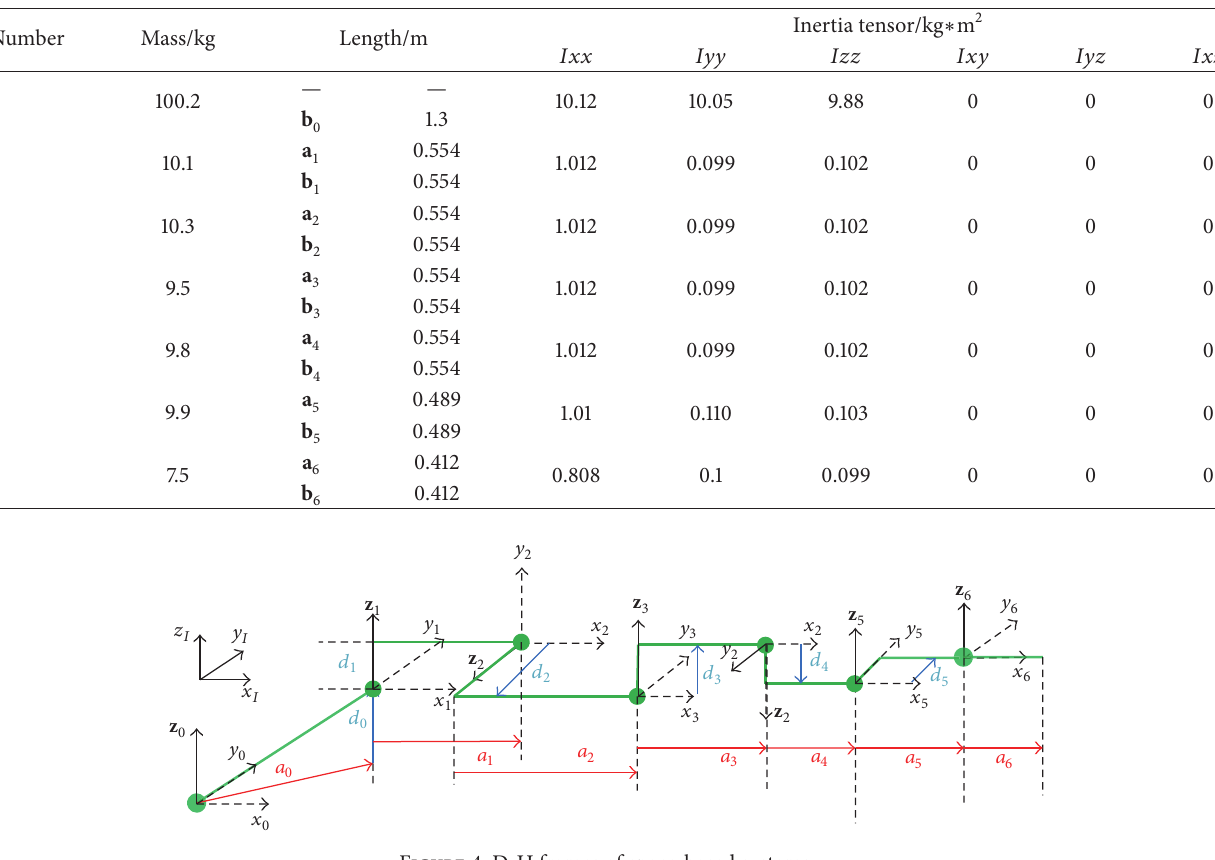
Table 1: Geometrical and inertial parameters of a system.